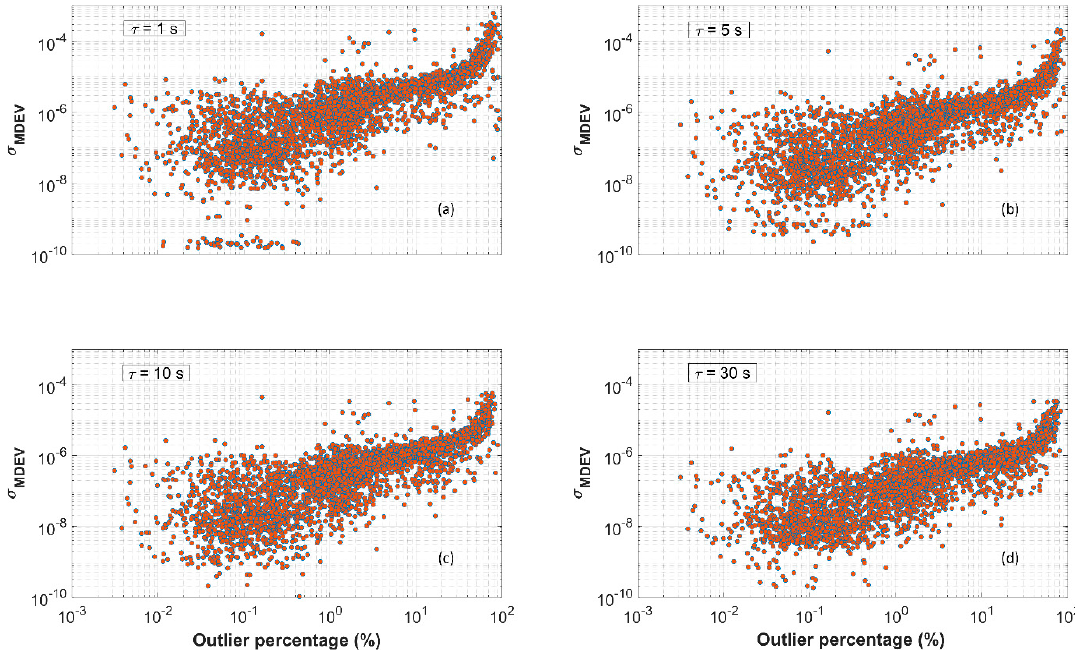
Figure 4. MDEV of the 17 CubeSats’ clocks for short averaging times plotted against the percentage of the observations that are considered outliers in the pre-processing steps. In the subfigures, each dot represents the MDEV of one observation segment for one CubeSat over the testing period. The subfigures ( a – d ) indicate averaging times 1, 5, 10, and 30 s, respectively. Table 3. Mean values of the MDEV changes of the CubeSats’ clocks when the numbers of stochastic accelerations are doubled compared to the default settings for the CubeSats observations with a high rate of outliers